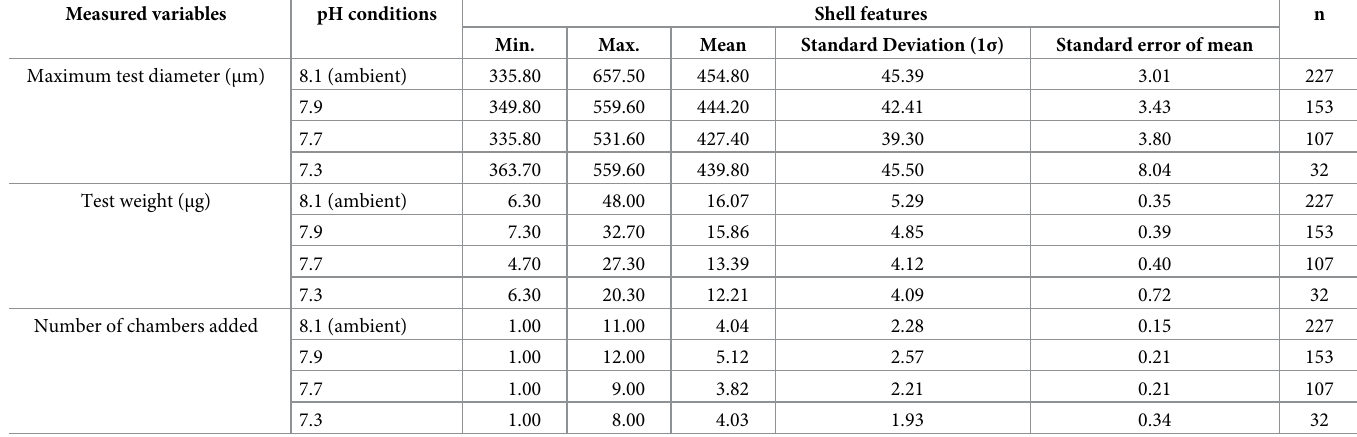
Table 2. Maximum shell diameter ( μ m), shell weight ( μ g), and the number of chambers added and their standard deviation and standard error of the mean for Elphidium williamsoni across four different pH